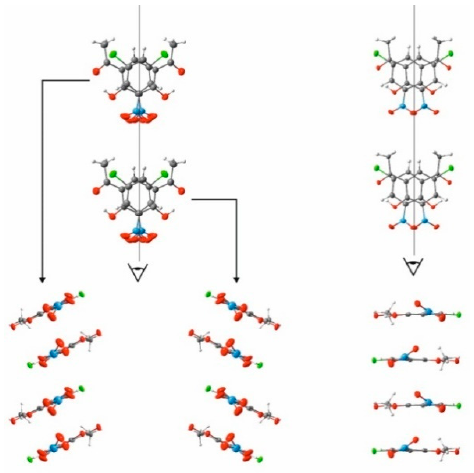
Figure 12. The fragments of packing of two polymorphic states of 5-chloro-3-nitro-2-hydroxy-acetophenone. Reprinted from Ref. [54]. Copyright 2019, The American Chemical Society. 150 K